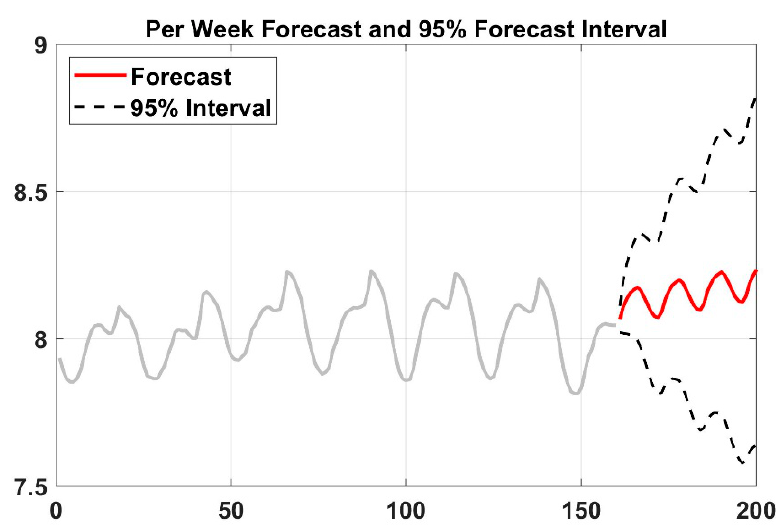
Figure 26. Per day forecasting validation using MC.